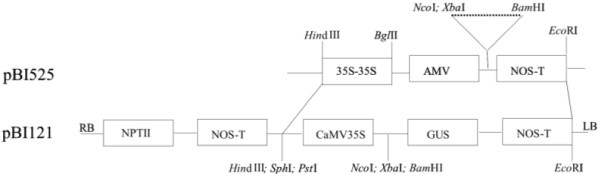
Constructs developed for plant transformations. PCR amplicons of the ORF and full-length LeAox1au gene were cloned into pBI525 at the XbaI and BamHI sites (dashed line). The resulting fragment was excised from pBI525 at the Hind III and EcoR I sites and ligated into pBI121 to form the transformation constructs.